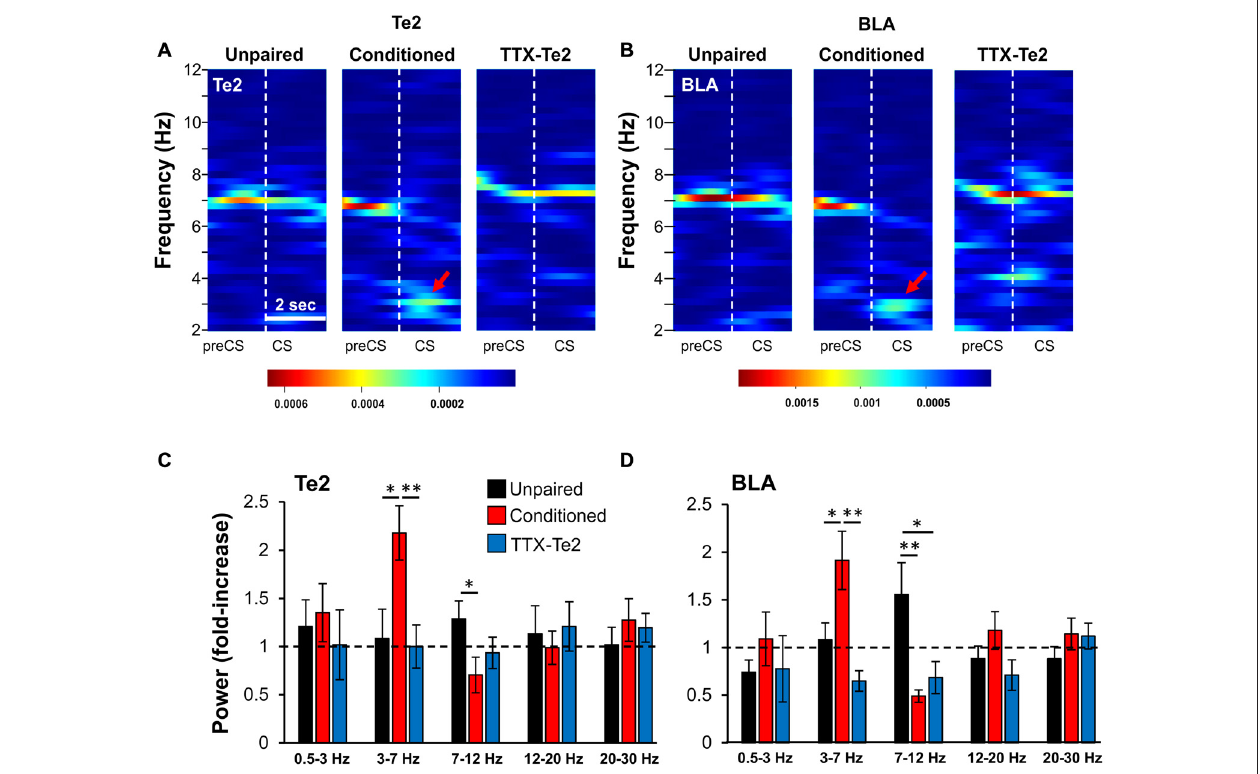
FIGURE 3 | Blocking Te2 during consolidation precludes its activation, as well that of BLA during the early phase of long-term fearful memory recall. Representative spectrograms of Te2 (A) and BLA (B) activity around the first CS onset (2 s) in an unpaired ( n = 10), a conditioned ( n = 12) and a TTX-treated animal (TTX-Te2; n = 9). Red arrows indicate the increased activity in the low-theta range. The TTX-treated group showed a low- theta activity similar to the unpaired group in both Te2 (C) and BLA (D) while conditioned rats displayed an increased low-theta and a decreased high-theta activity in both areas with respect to unpaired and TTX-treated rats (sign-rank, P < 0.05). All data are expressed as mean ± SEM. ∗ P < 0.05; ∗∗ P <